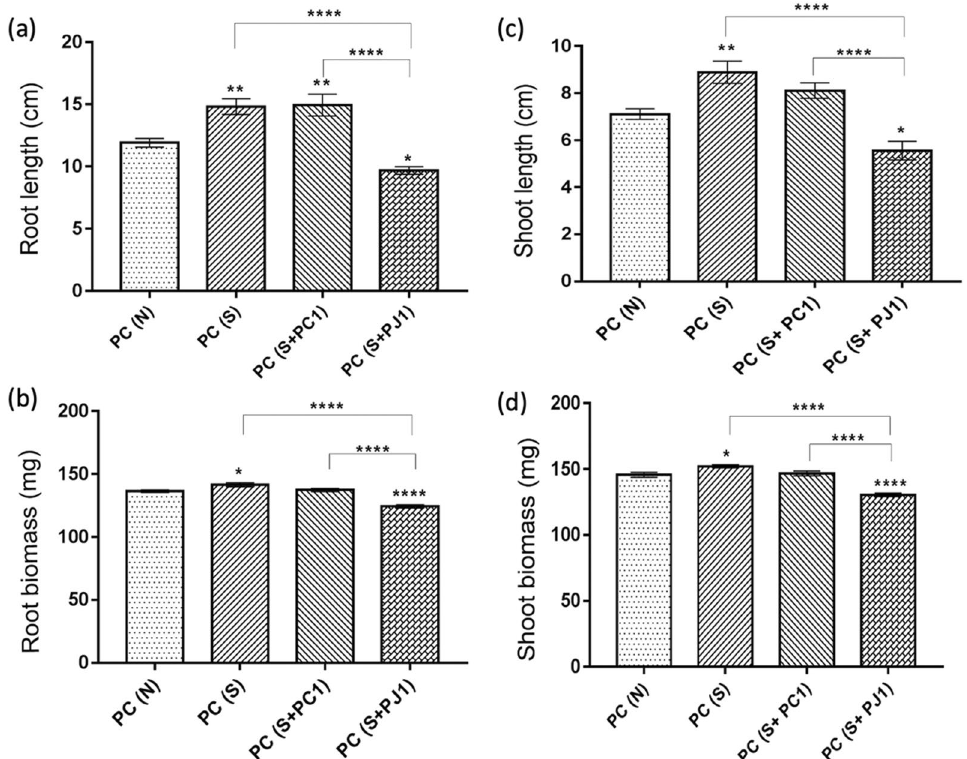
Fig. 5 Effect of soil inoculum on root length ( a ), root biomass ( b ), shoot length ( c ) and shoot biomass ( d ) of Prosopis cineraria . PC: Prosopis cineraria ; PJ1: Streptomyces isolated from Prosopis juliflora rhizosphere; PC1: Streptomyces isolated from P. cineraria rhizosphere; (N), natural garden soil; (S), sterilized soil. All statistical analyses were carried out using one-way ANOVA followed by Tukey’s post hoc test. n *** p < 0.001, **** p < 0.0001. Error bars represent standard